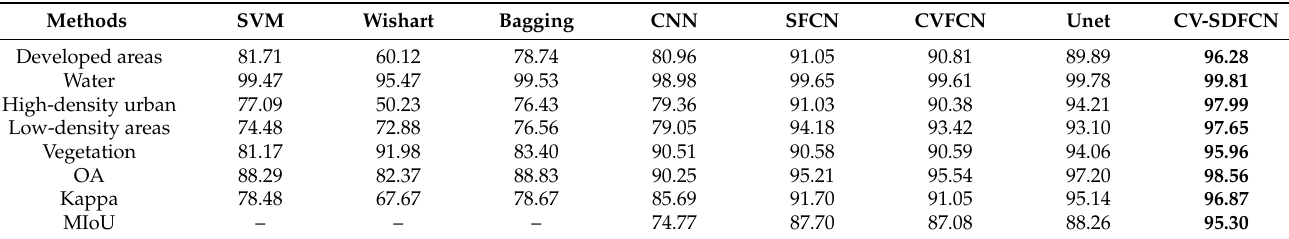
Table 3. Classification accuracy of San Francisco dataset ( % )